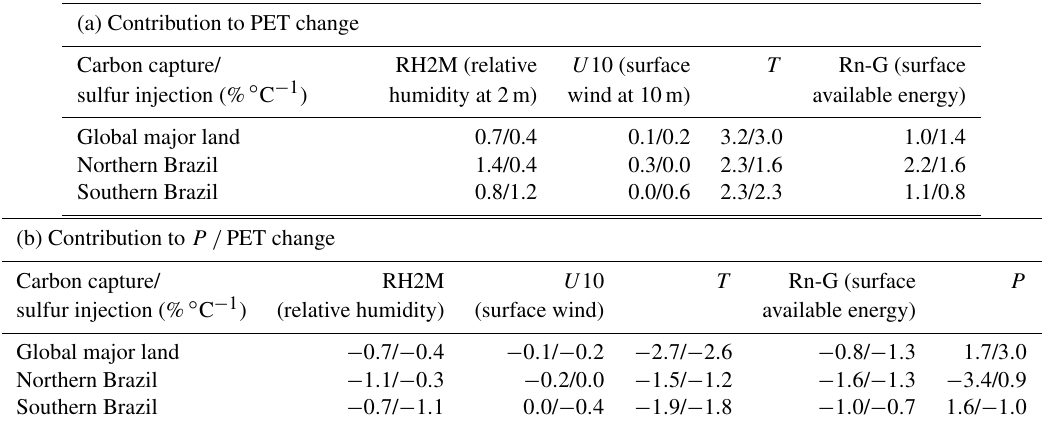
Table 5. Change (% ◦ C − 1 ) in PET and P / PET due to contributions of other climate variables (RH2M, U 10, T , Rn-G, P ). The variables used for this table are not bias-corrected because of the lack of a reliable benchmark for U 10 and Rn-G (surface-available energy, which is the incoming radiation reaching the ground minus the heat flux into the